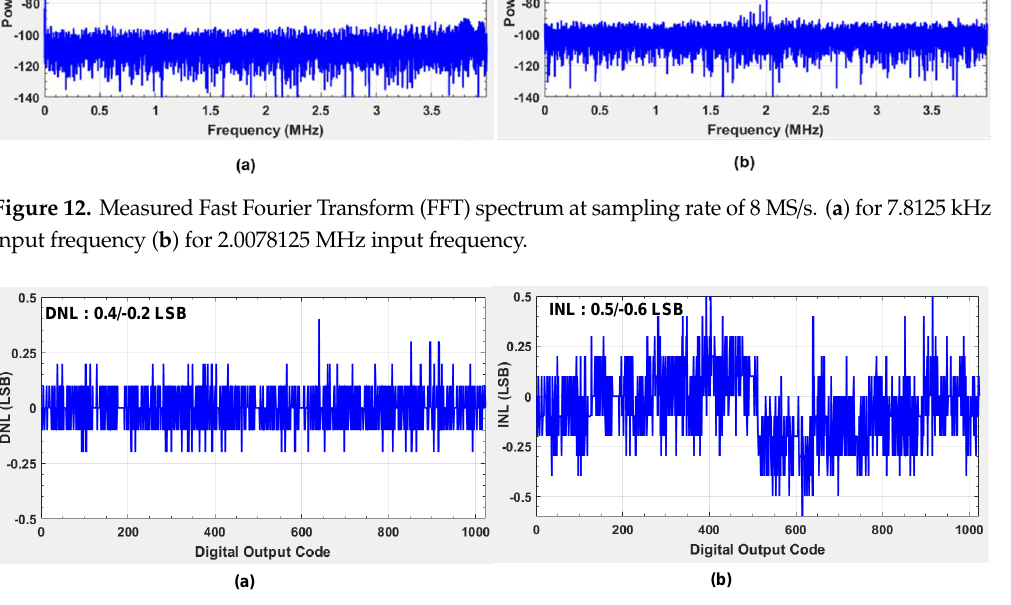
Figure 13. Measured static performance ( a ) differential non-linearity (DNL) ( b ) integral non-linearity (INL).